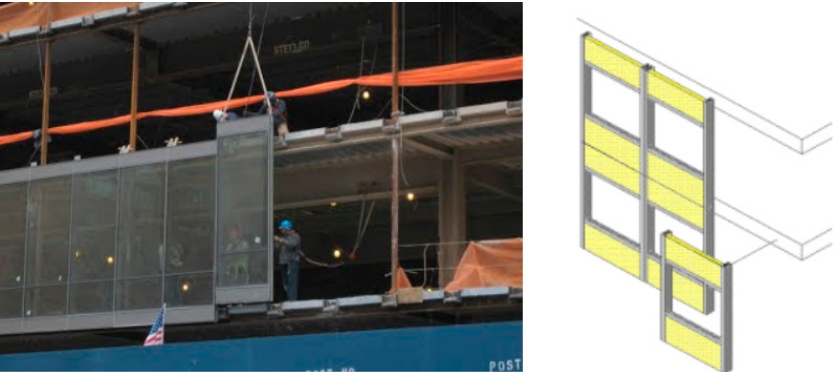
Figure 4. Unitized Curtain Wall [12].